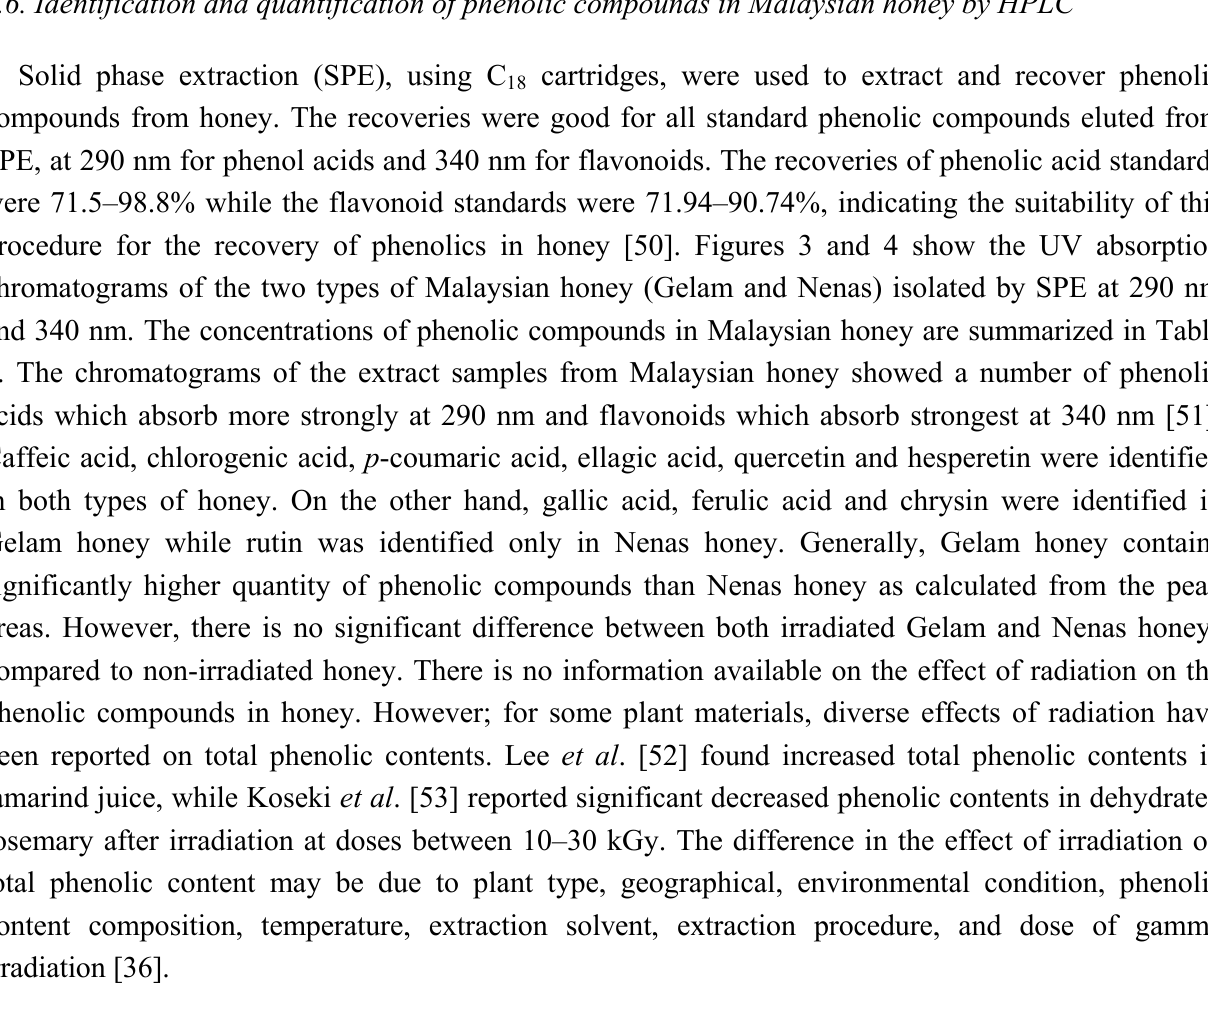
Figure 3. Chromatogram of Phenolic acid and Flavonoids detected in Malaysian Gelam honey using HPLC-UV absorption at (I) 290 nm and (II) 340 nm. A = gallic acid, B = chlorogenic acid, C = caffeic acid, D = p -coumaric acid, E = ferulic acid, F = ellagic acid, G = quercetin, H = hesperetin, I =